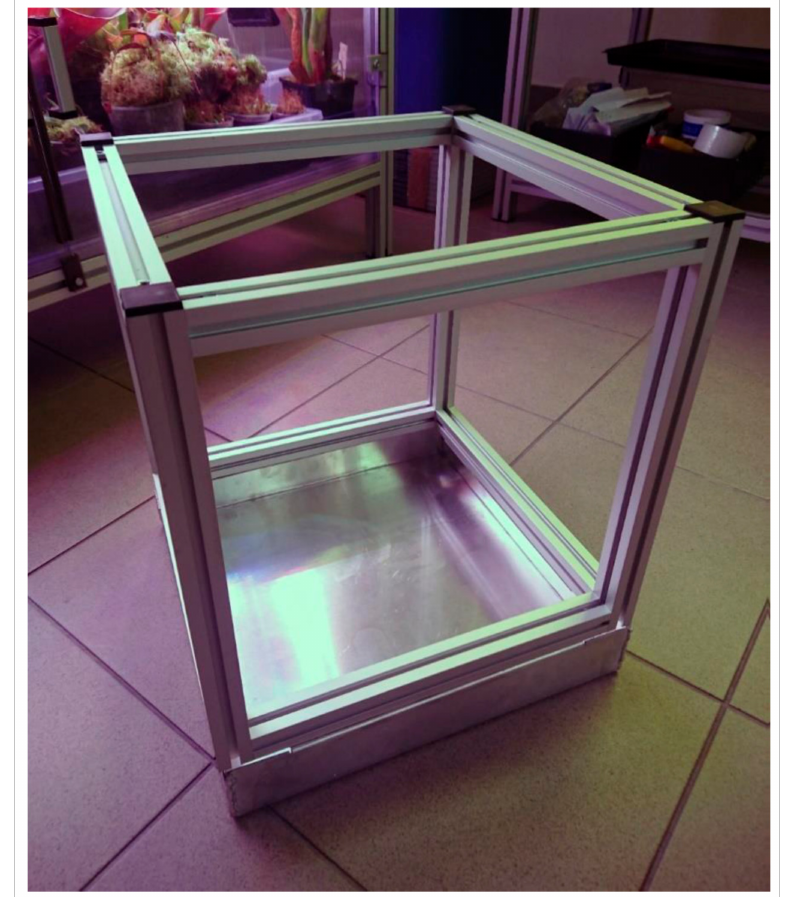
Figure 4. Aluminum profile frame of the